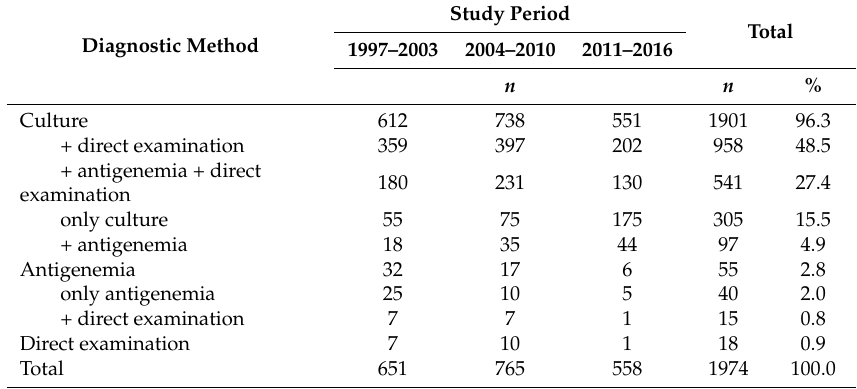
Table 3. Diagnostic procedures used in Colombian cryptococcosis patients,